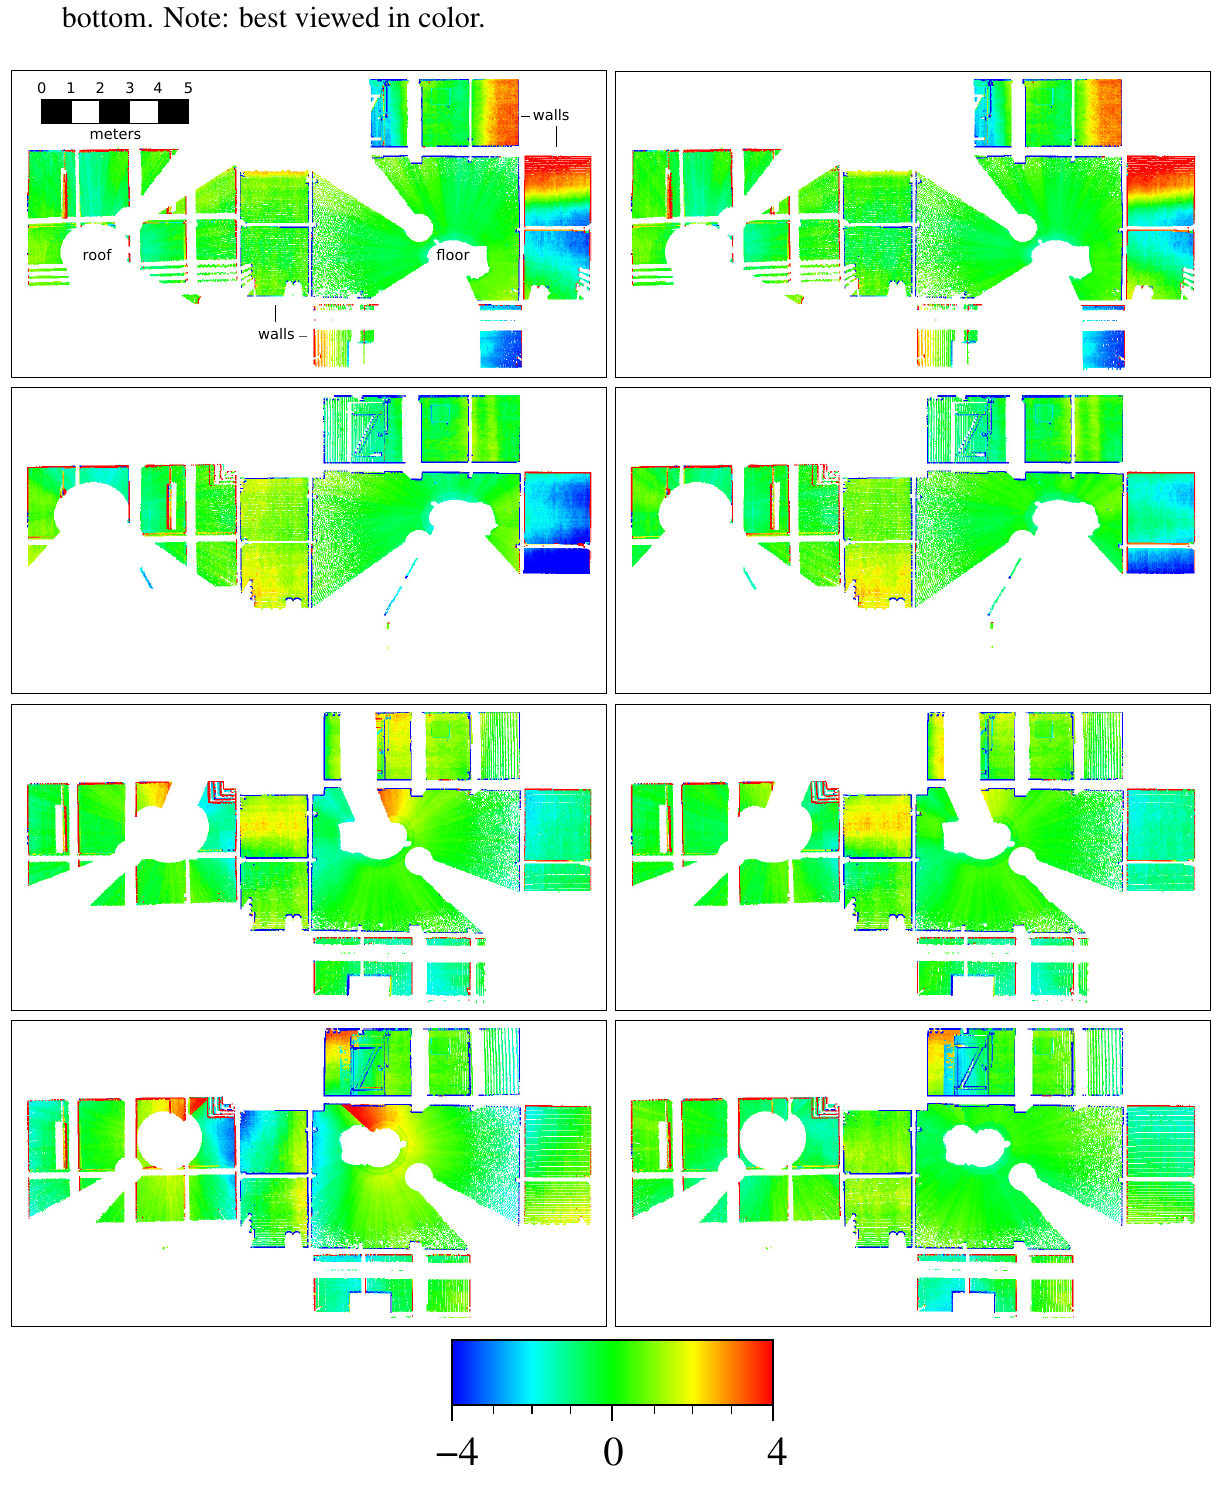
Figure 6. Comparison of the acquired laser scans with the model using the manual ( Left ) and the automatic calibration ( Right ) for representative excerpts of the four Basement 1 datasets acquired with Irma3D. Deviations in centimeters (cm) are color-coded as indicated on the bottom. Note: best viewed in